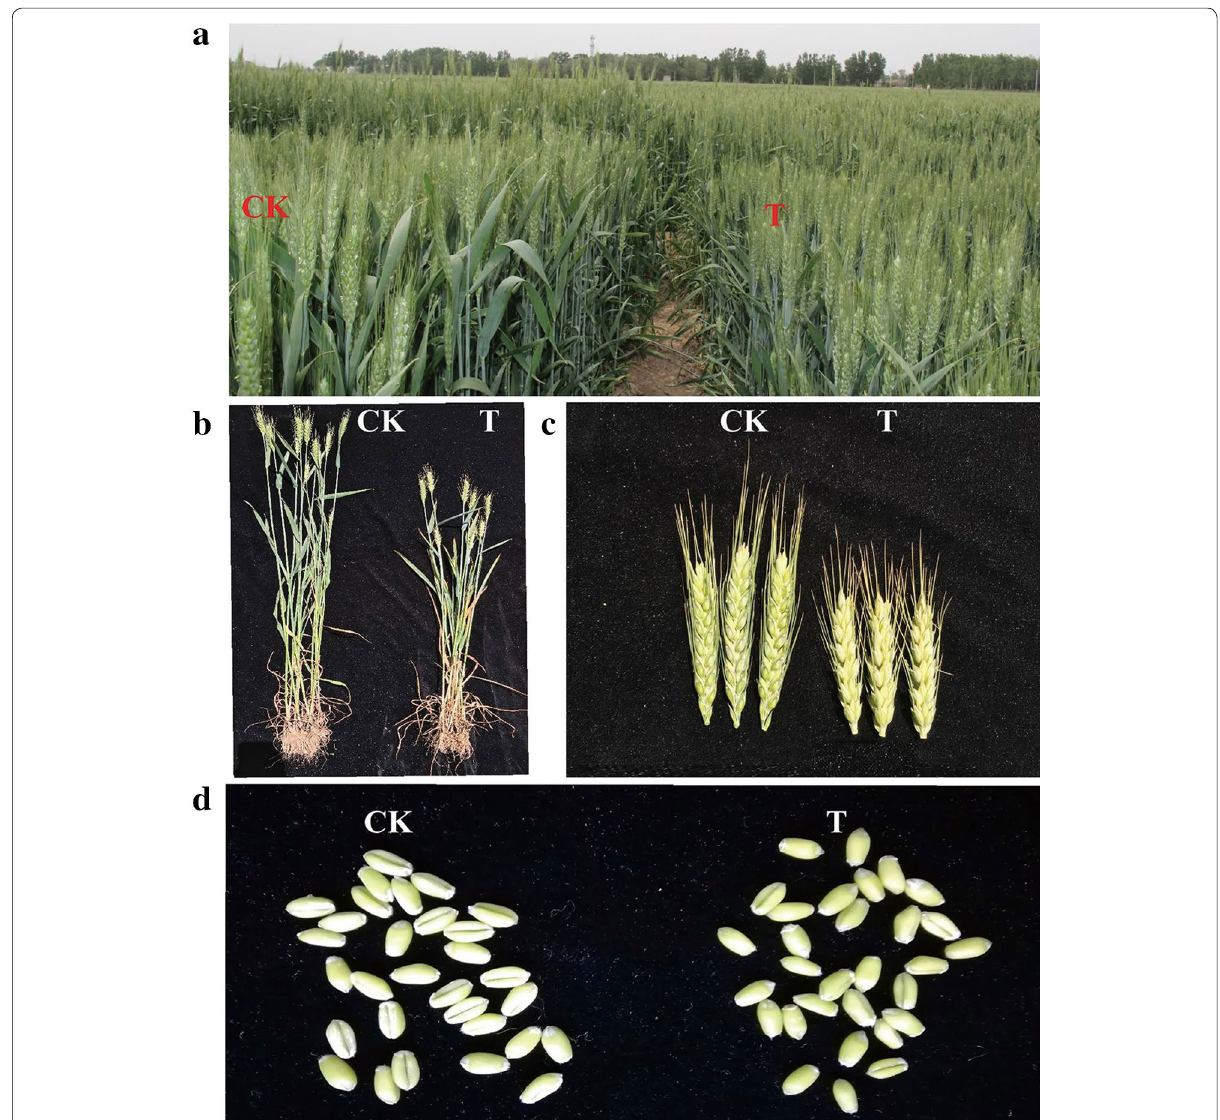
Fig. 2 Plant phenotypes under stress treatment and CK. a , b Plant height compared at 20 DPA between CK and drought treatment groups. c Ear length at 20 DPA under drought treatment. d Grain appearance at 20 DPA under drought